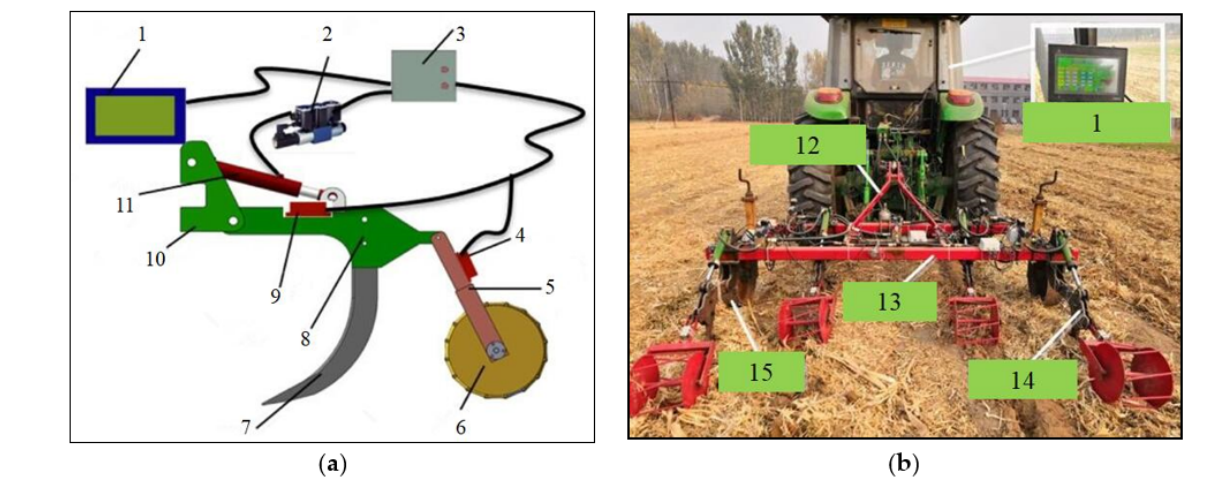
Figure 4. ( a ) Subsoiling assembly with the electric-hydraulic control system (Wang et al., 2018); ( b ) Subsoiler equipped with four subsoiling assemblies with the electric-hydraulic control system (Wang, 2019).